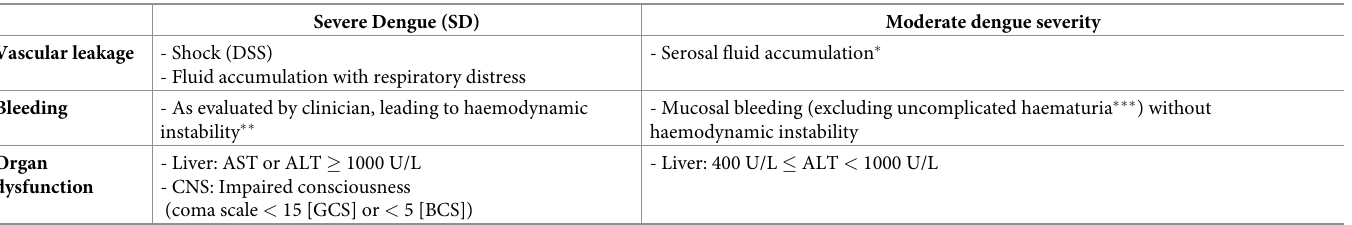
Table 2. Severe Dengue (SD) according to the WHO 2009 dengue classification, and moderate dengue according to the definitions used for this